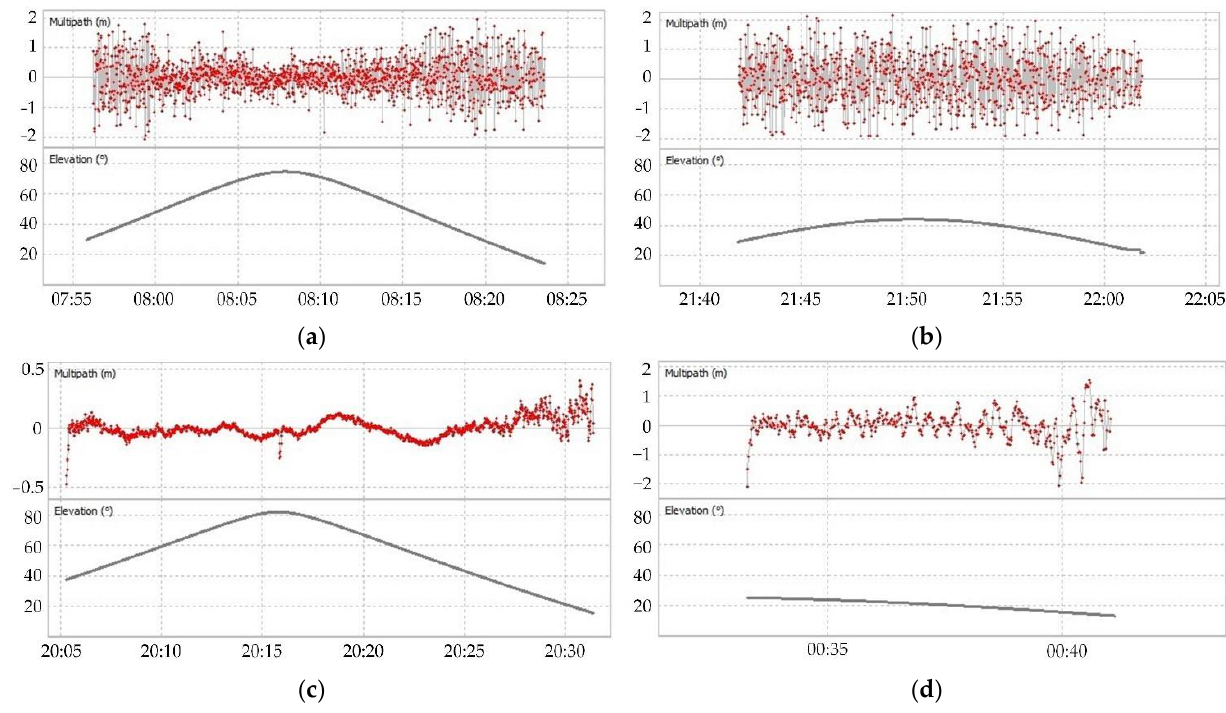
Figure 1. Multipath effects of HY-2D and G03 on DOY 266 in 2021. ( a , b ) MP1; ( c , d ) MP2. The multipath error, cycle slips, and data completeness of the 7 days of satellite-borne GPS data were calculated and tabulated in Table 1. The errors of MP1 and MP2 were 0.35 and 0.23 m, respectively, and MP1 was about 1.5 times that of MP2. The HY-2D observation of DOY 265 was missing in the period from 19:49 to 23:27, resulting in a significantly lower than average data completeness and utilization rate. Table 1. HY-2D data quality